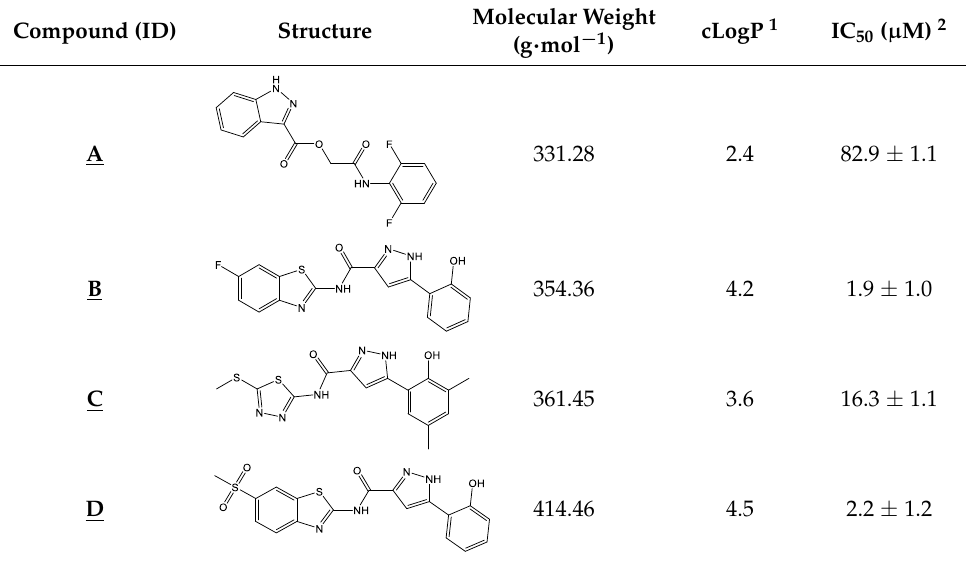
Table 1. Chemical structures, physical-chemical properties (molecular weight and cLogP values) and IC 50 values obtained for four ecto -5 ′ -NT inhibitors ( A, B, C and D ) selected by VS. Compound (ID)